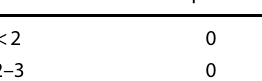
Table 3 Number of earthquakes with reference to earthquake magnitude class